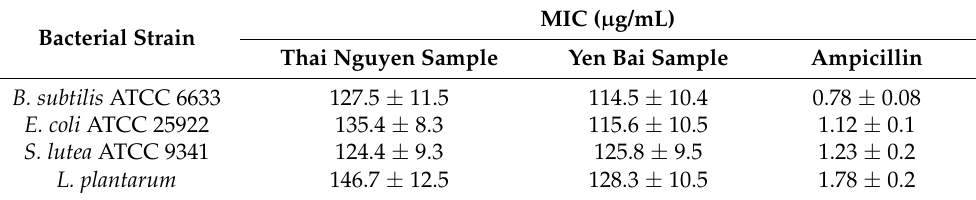
Figure 2. GC-FID spectra of EOs extracted from C. verum bark cultivated in Thai Nguyen or Yen Bai, with n-hexane used as the extraction solvent. Table 4. Anti-microbial activities of C. verum bark EOs extracted by water distillation method. The values represent the averages of three replicates and statistical differences are considered at p -value < 0.05.